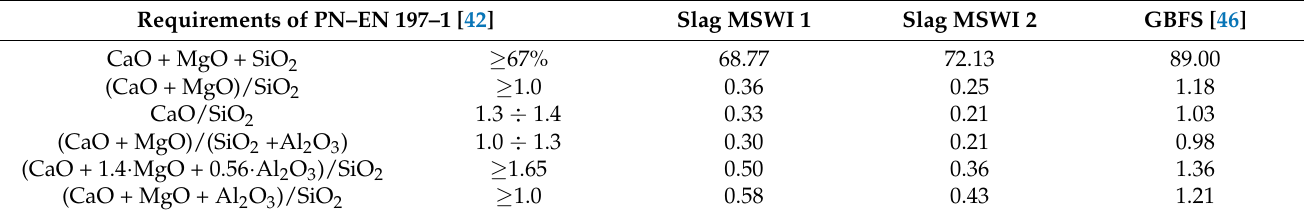
Table 5. Properties of tested slags in relation to the standard requirements of PN–EN